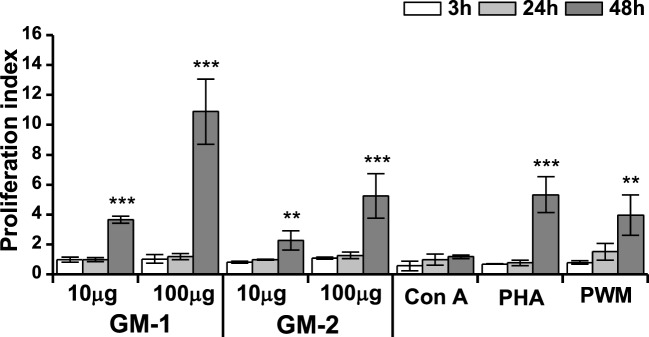
Effect of glycoconjugates GM-1 and GM-2 on proliferation of RAW264.7 macrophages. Cell proliferation was determined by ViaLight™ plus kit. RAW264.7 cells were treated with glycoconjugates GM-1 or GM-2 at concentrations of 10 and 100 µg/mL and with concanavalin A (Con A, 10 µg/mL), phytohemagglutinin (PHA, 10 µg/mL) and pokeweed mitogen (PWM, 1 µg/mL) as positive controls for 3, 24, and 48 h. Each value presents the mean ± SD of proliferation index (ratio of average relative light units (RLU) in the presence of stimulant to average relative light units obtained without stimulation). According to calculation formula of proliferation index, the proliferation index of negative control-untreated cells is equal to one. The statistical significance of differences between stimulated cells and untreated cells using one-way ANOVA and post hoc Bonferroni’s tests is expressed: **—0.001 < P < 0.01, ***—P < 0.001.